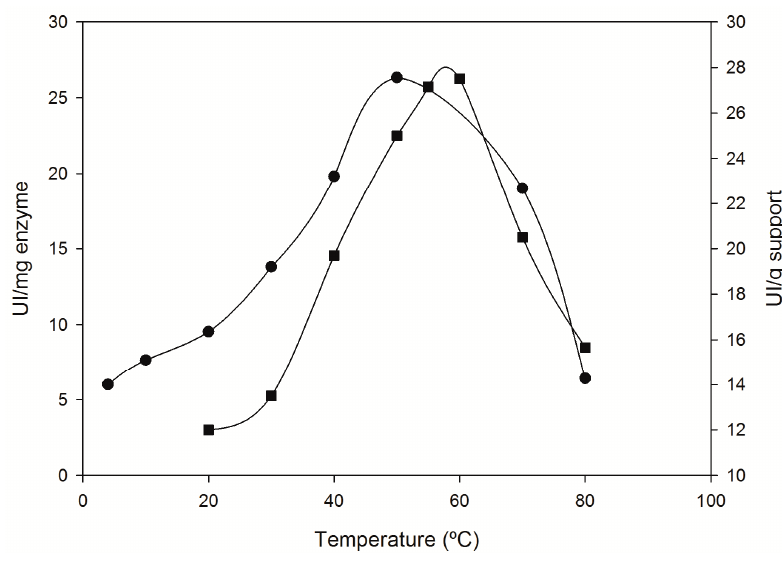
Figure 4. Effect of temperature on enzyme activity of free (  ) and immobilized (  ) Bp NDT (PA9 Bp NDT biocatalyst). Enzyme activity was assayed in 50 mM HEPES buffer pH 8, as described in the Experimental